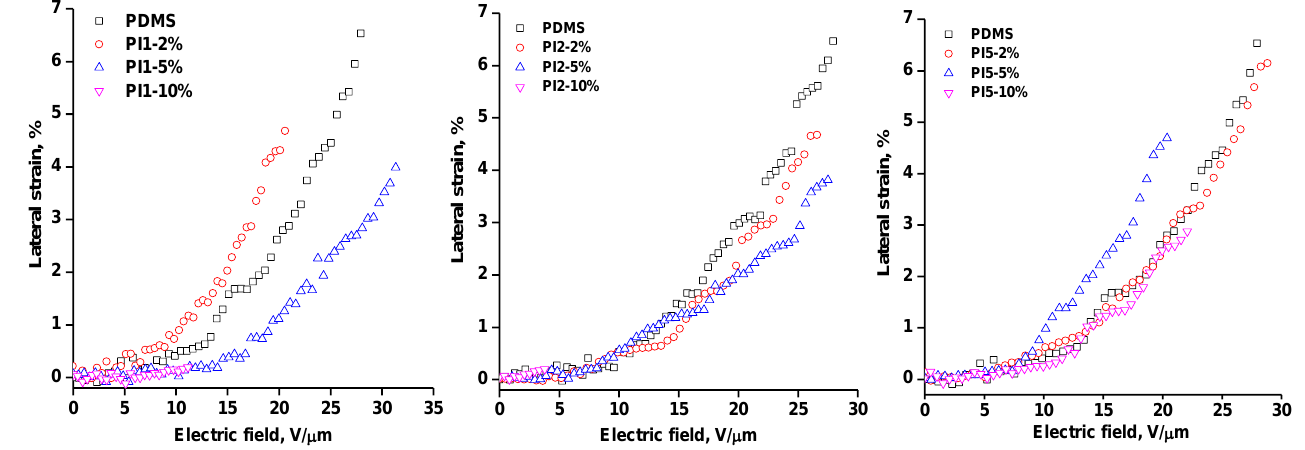
Figure 6. Dielectric actuation of the composite films.